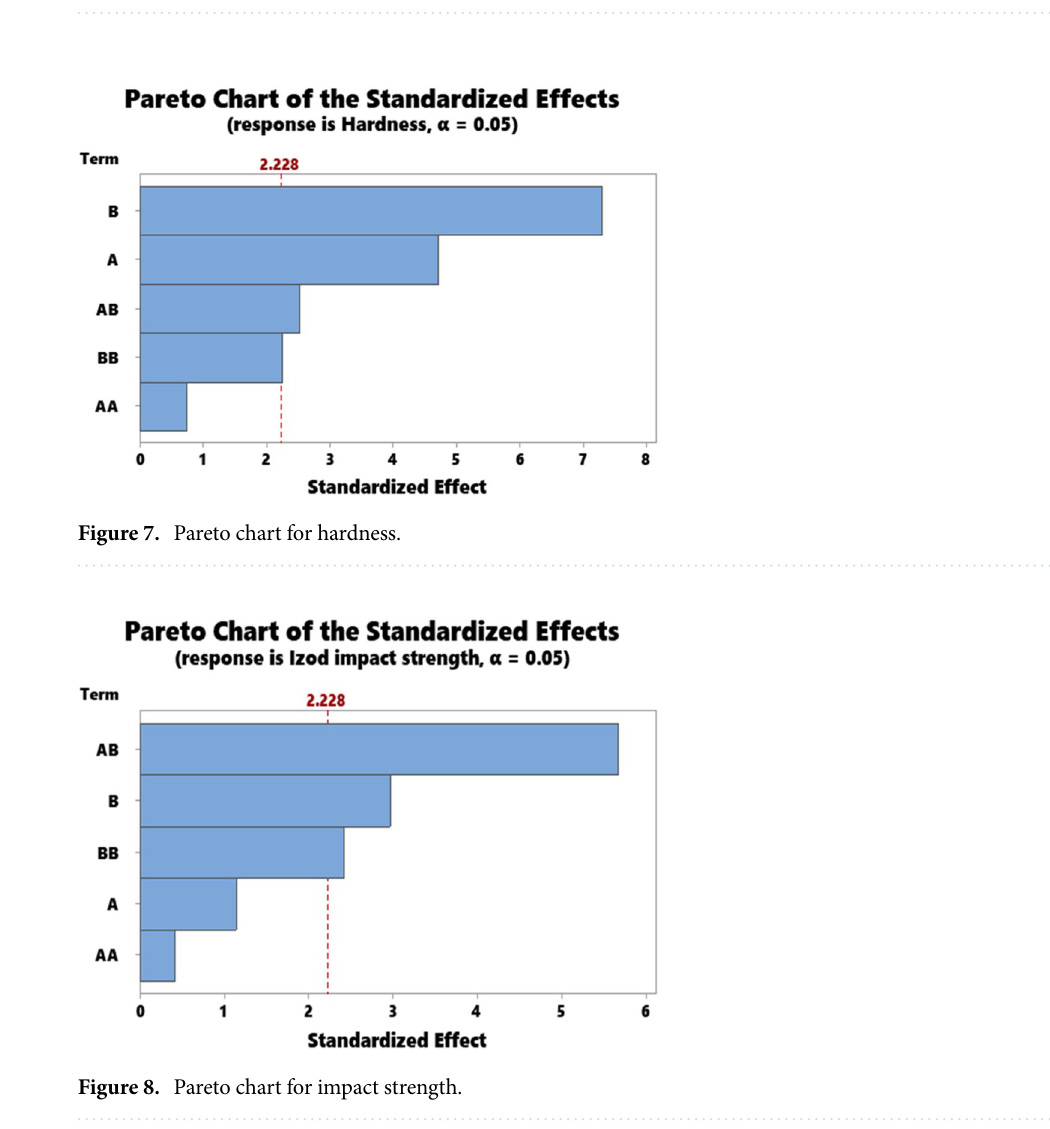
Table 7. ANOVA for tensile strength.